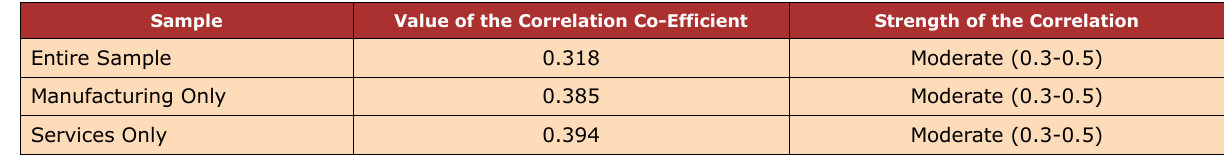
Table 8. Correlation between Motivations for and Benefits of ISO 9001